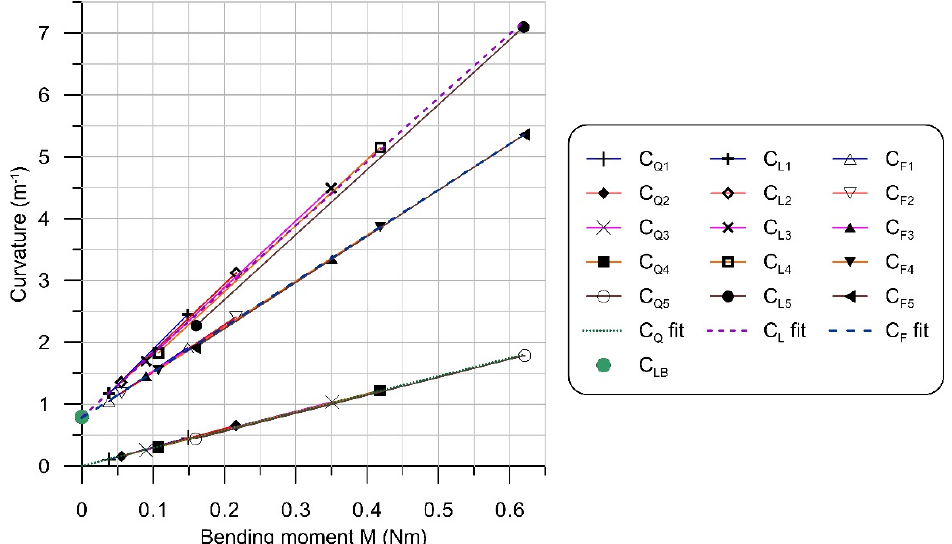
Figure 14. Curvatures after mechanical loading ( Q C ), laser heating ( L C ) and complete unloading ( F C ), as functions of the bending moment M . Numerical index in the legend denotes the load case case number.